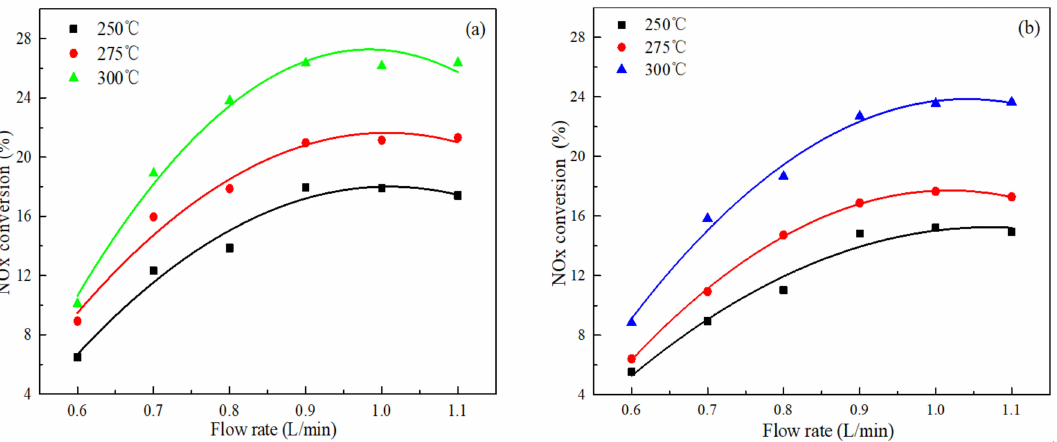
Figure 1. Effect of flow rate on NO x conversion over the SOC and SSOC-5 ( a ) SOC, W/F = 0.9 kg · s · L − 1 ; ( b ) SSOC-5, W/F = 0.36 kg · s · L − 1